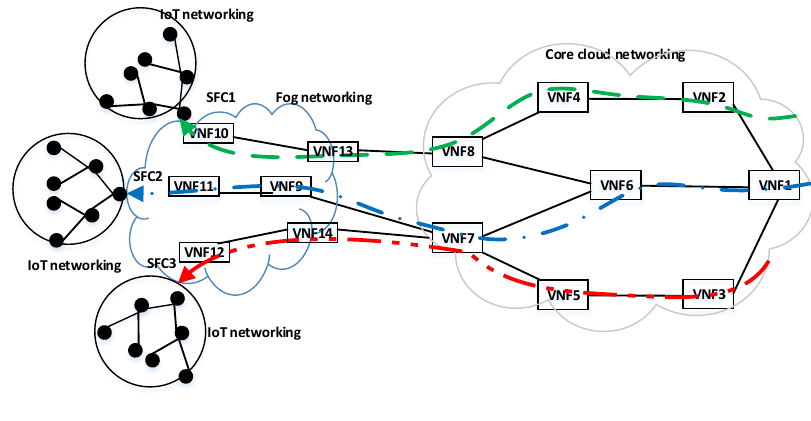
Figure 1. Fog-core cloud service function chains (SFCs) for IoT applications. Each SFC is deployed through a chain of virtual network functions (VNFs) across the core cloud and fog networking to serve end IoT